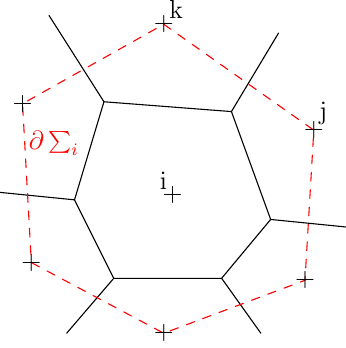
Figure 2. Gradient computation: Stokes formula is applied on the boundary ∂(cid:54) i of the polygon surrounding cell i . The vertices of (cid:54) i are the barycenters of nearest-neighbor cells j , k ,